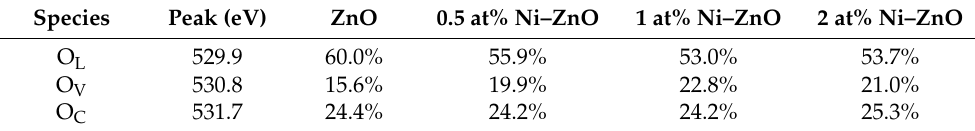
Table 1. The relative percentages of O 1s in the XPS spectra ZnO, 0.5 at%, 1 at%, and 2 at% Ni–ZnO.